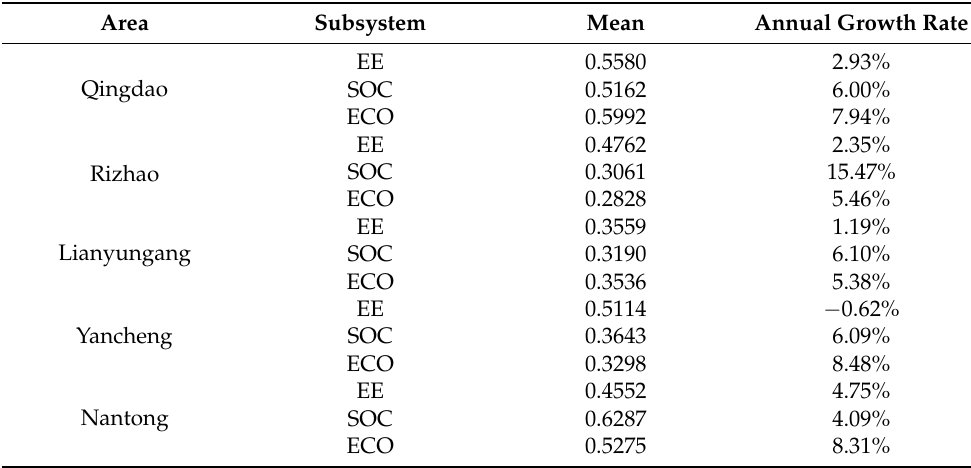
Figure 3. Trends in development levels in each subsystem. Table 4. Mean index of coastal zone subsystem